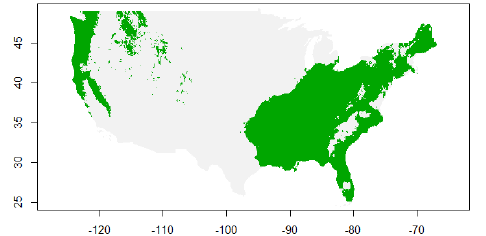
Figure 1. High Precipitation Area of US mainland in 1950